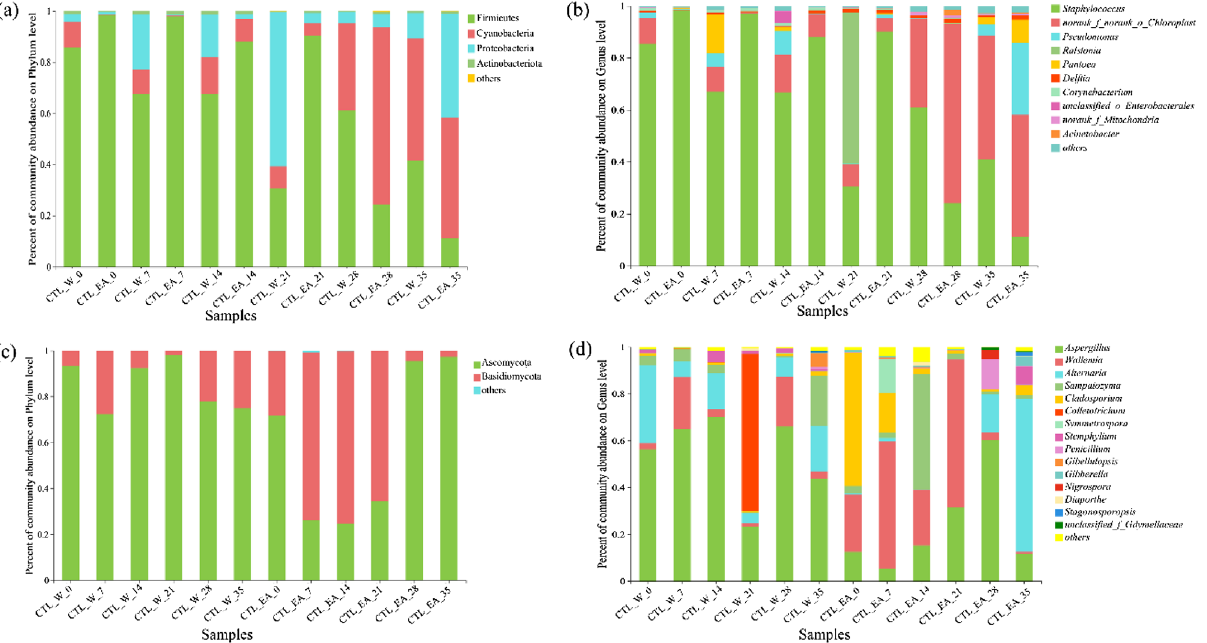
Figure 5. Relative abundance of bacterial community on phylum level ( a ) and species level ( b ) in different CTL samples; relative abundance of fungal community on phylum level ( c ) and species level ( d ) in different CTL Figure 5a showed the changes of bacterial communities on phylum level during the fermentation. Four differ- ent phyla, including Firmicutes , Cyanobacteria , Proteobacteria , and Actinobacteriota , were identified among these CTL samples. In the water-group, the relative abundance of Firmicutes decreased with prolonging fermentation time, whereas that of Cyanobacteria increased. After fermentation, the relative abundances of Firmicutes and